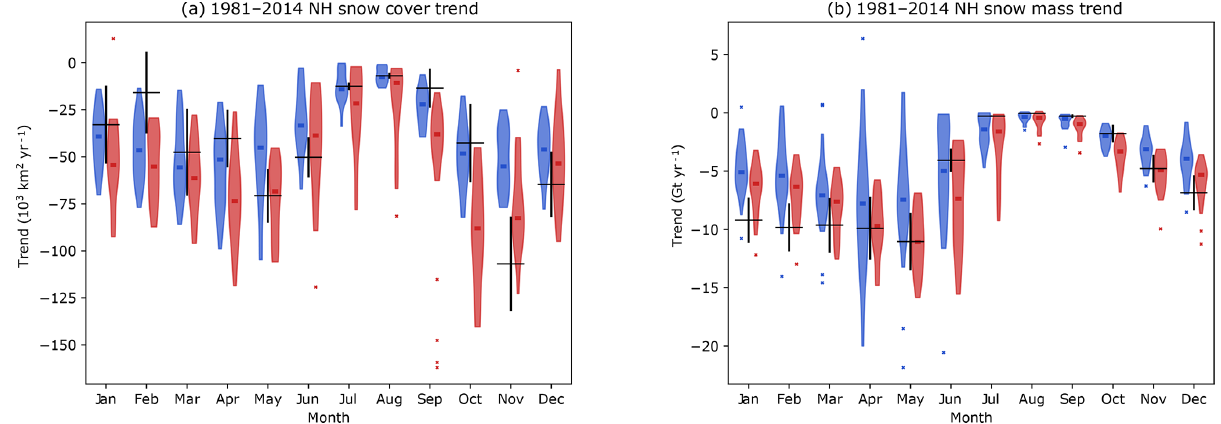
Figure 6. Northern Hemisphere trends of snow extent (a) and snow mass (b) between 1981 and 2014, for CMIP5 (blue) and CMIP6 (red). The violins span the model range after the removal of outliers. The observed trends are represented by the black crosses, with the height of the cross representing the 1 σ uncertainty of the observed trend.